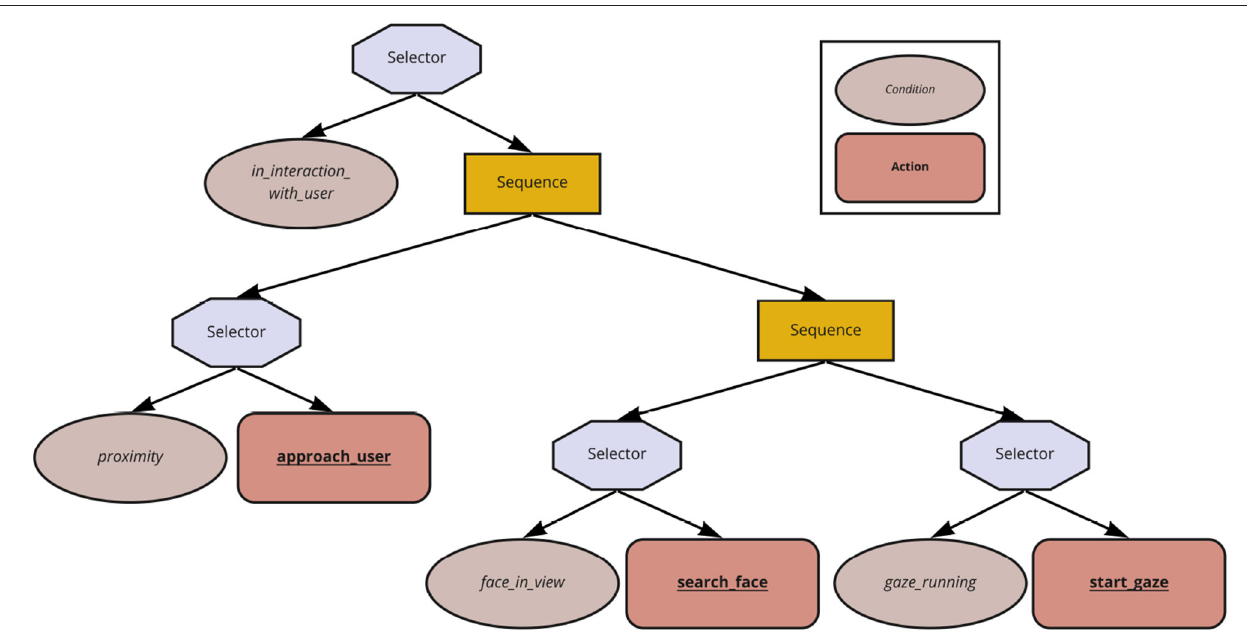
FIGURE 6 | Example Behavior Tree for StrategyInitiateContact : The octagons represent selector nodes, rectangles represent sequence nodes, ellipses represent condition nodes, and rounded rectangles represent action